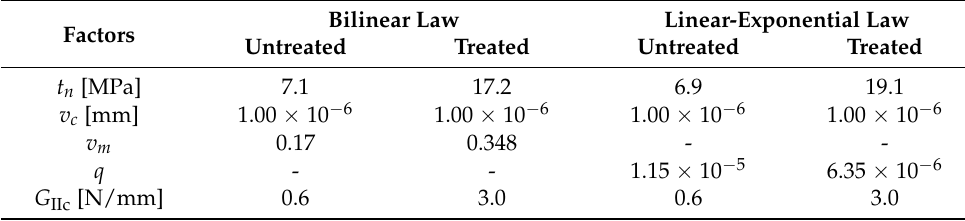
Table 6. Cohesive parameters obtained for bilinear and linear-exponential law. Bilinear Factors